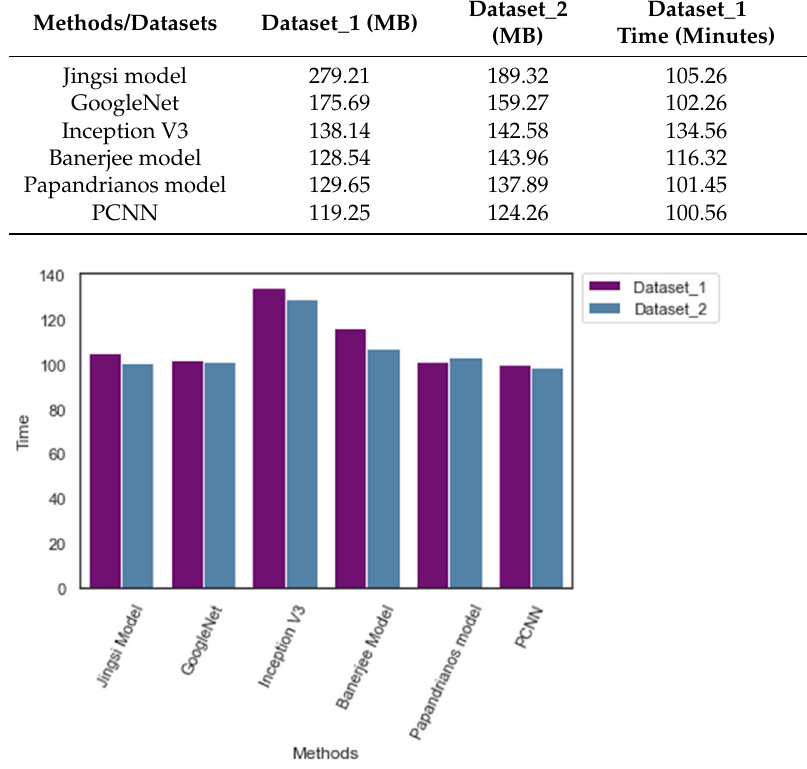
Figure 12. Computation time of CNN models.